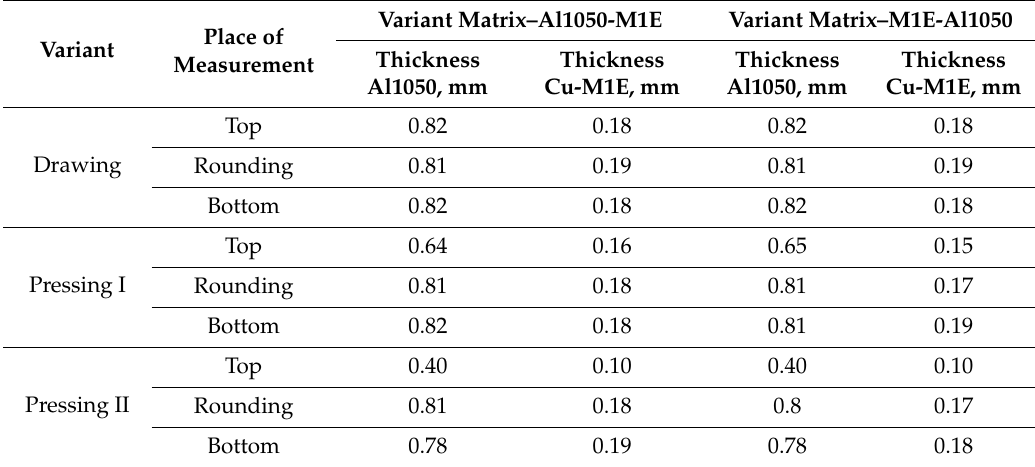
Figure 10. Welding area after the last pressing process. ( a ) side-wall area matrix–aluminum variant; ( b ) side-wall area matrix–copper variant; ( c ) matrix–aluminum variant in the rounding of the sample; ( d ) matrix–copper variant in the rounding of the sample. Table 3. Results of measurements of average values of layer thickness for the examined